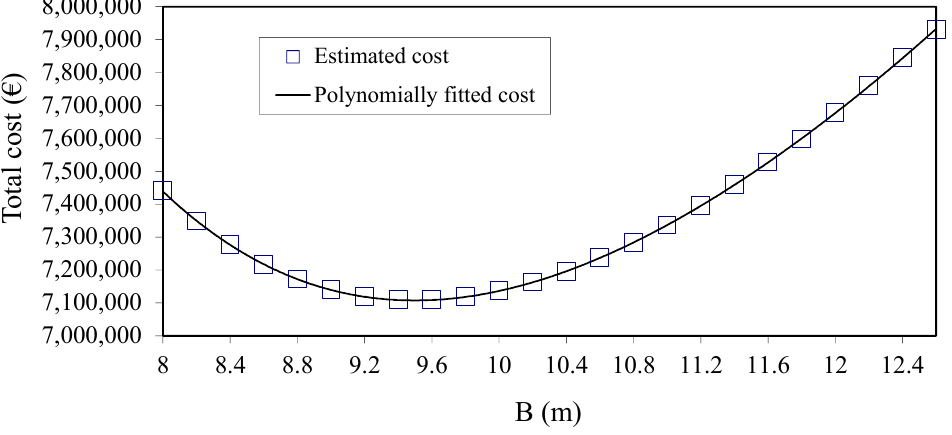
Figure 14. Total costs (€) as a function of the berm width, B (m), for h berm = 0.8 m.